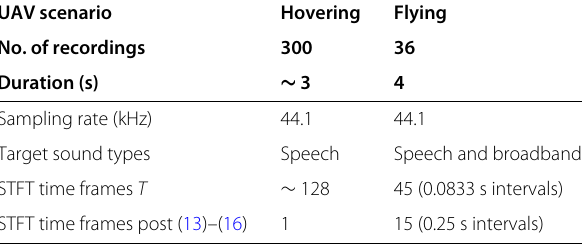
Table 1 Experimental problem setup